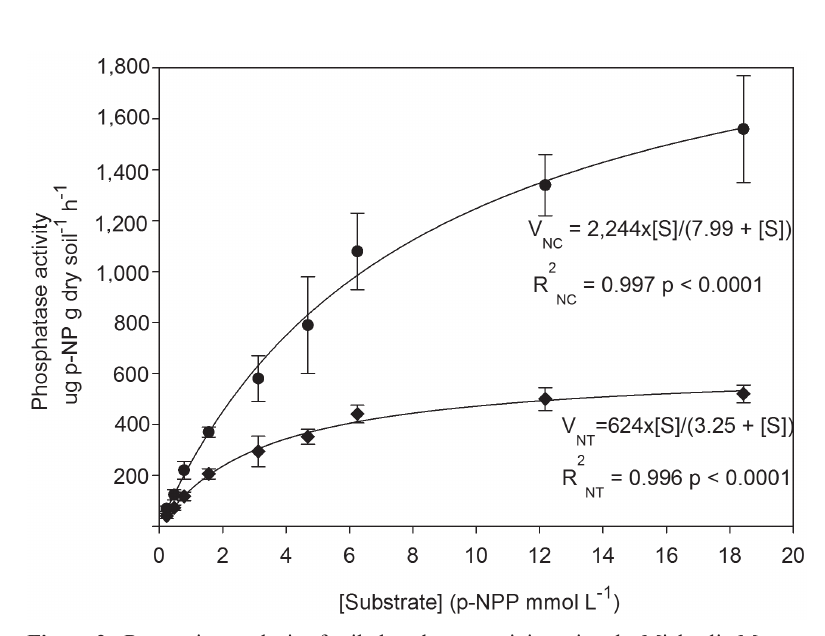
shows soil NC shows soil phosphatase NT